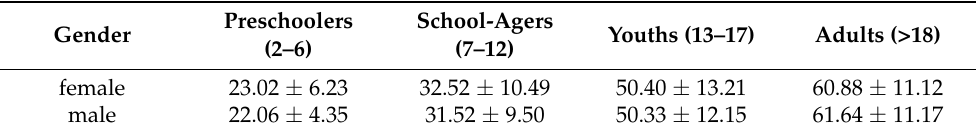
Table 3. Estimated lognormal probability density functions describing the ranges of body mass (kg) for groups in the